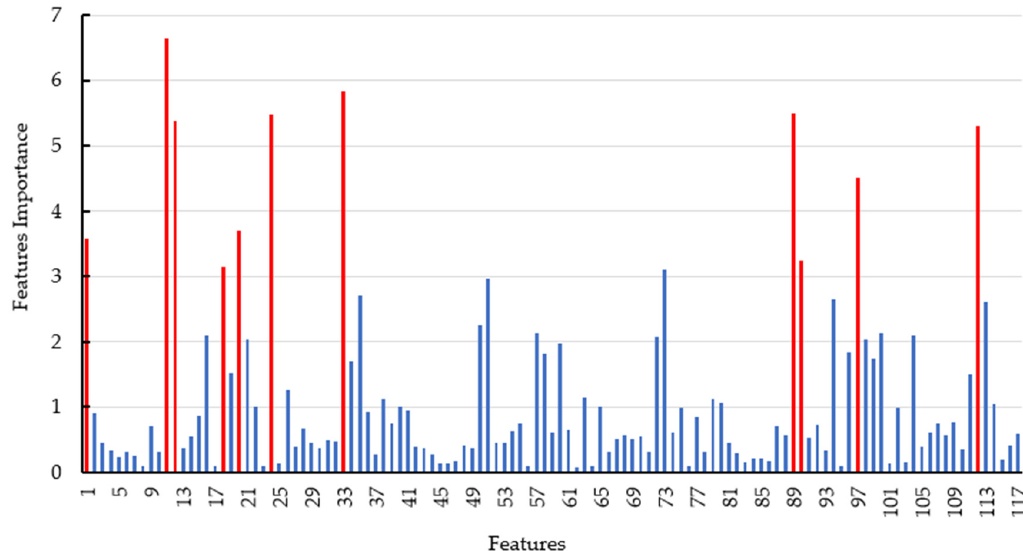
Figure 7. Bar graph of average values of the importance of 117 features extracted from 3 RADARSAT-2 images for dryland crop classification. Features 1–39, 40–78, and 79–117 were extracted from images acquired on 14 July, 7 August, and 24 September 2018, respectively. The names of features 1–39 are listed in Table 3. Features 40–78 and 79–117 have the same names as features 1–39. Red bars denote features ranking in the top 11 in terms of importance. Table 9. Confusion matrix of the 4 land cover types classified using 11 features and the random forest algorithm.